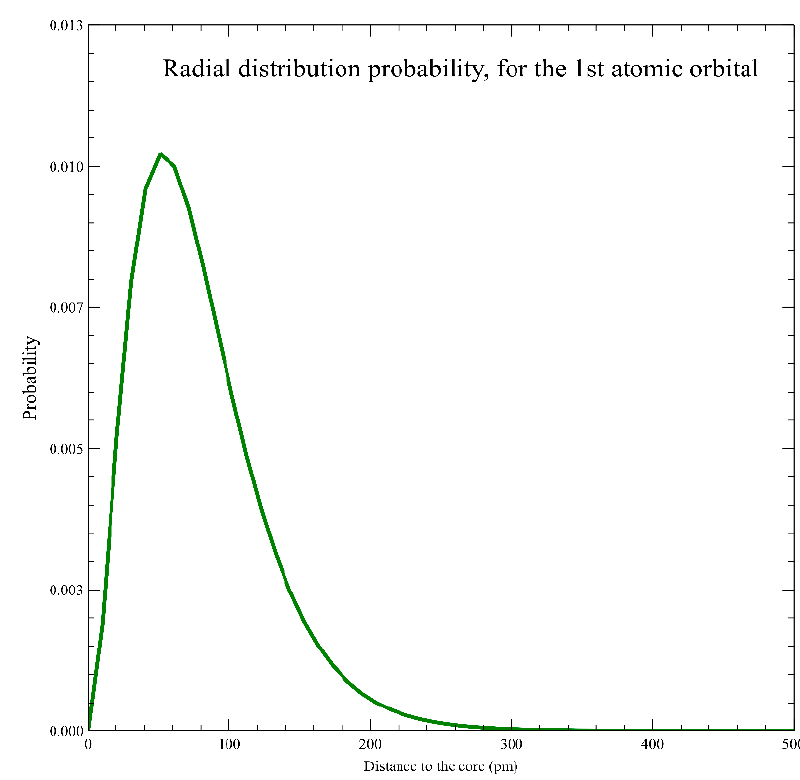
Figure 3. Radial distribution probability, for the 1st atomic orbital.